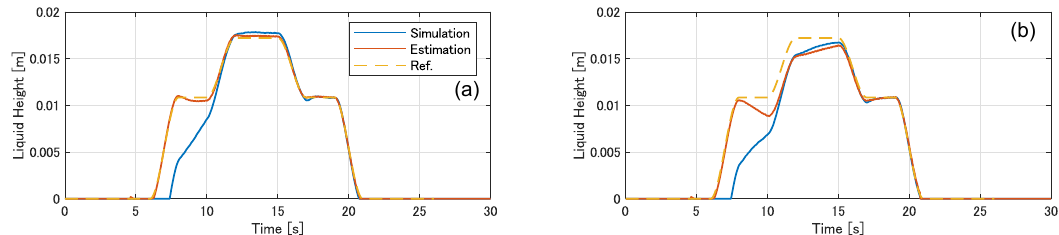
Figure 13. Comparative results of liquid height at pouring mouth. ( a ) Liquid height in developed flow rate control. ( b ) Liquid height in conventional feed-forward flow rate